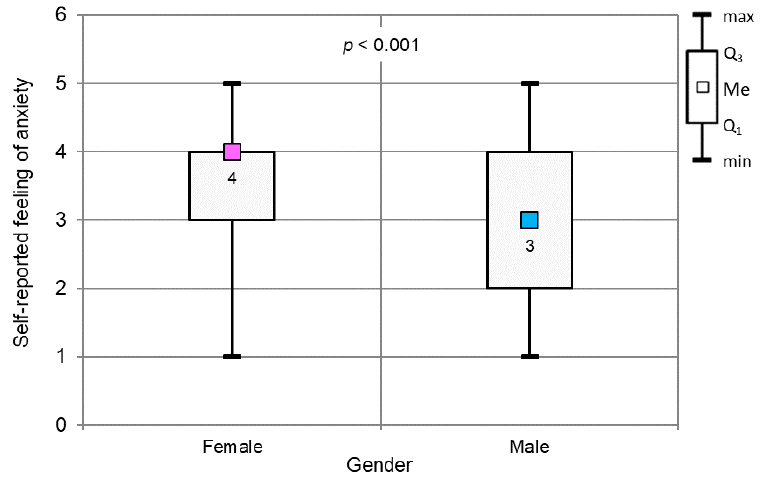
Figure 5. Self-reported anxiety level vs. gender ( p < 0.001, Mann–Whitney test). The Kruskal–Wallis test confirmed (KW = 32.32; p < 0.001) significant di ff erences among four groups of dentists: non-working females, working females, working males and non-working males (Figure